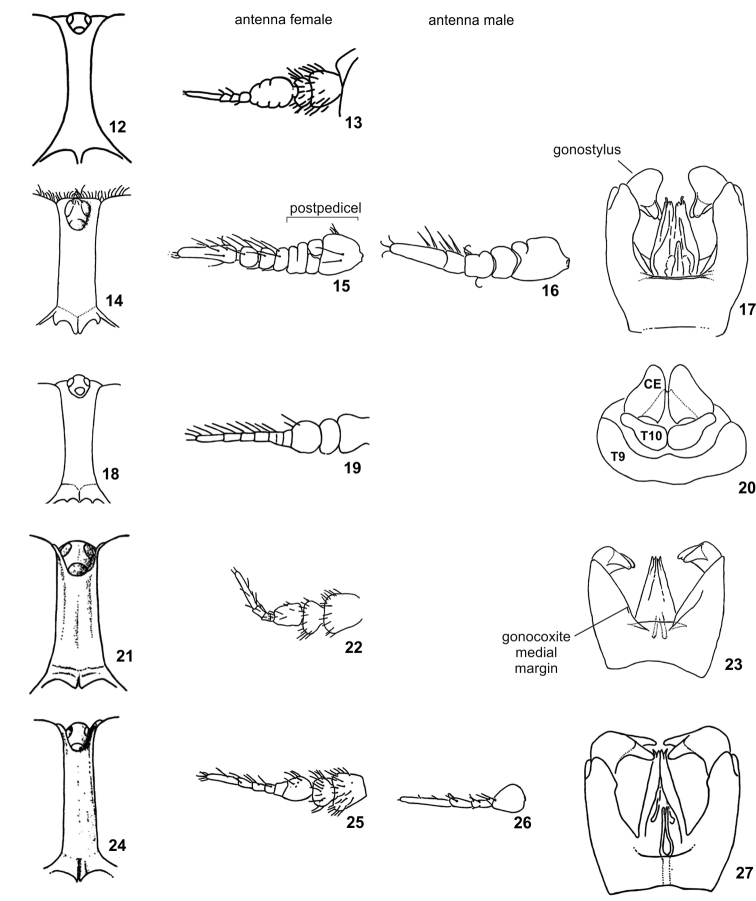
Protosilvius figures from Fairchild (1962). 12–13
Protosilvius longipalpis;12 frons 13 antenna, female 14–17
Protosilvius phoeniculus
14 frons 15 antenna, female 16 antenna, male 17 genitalia, male 18–20 Protosilvius termitiformis
18 frons 19 antenna, female 20 tergite 9, tergite 10 and cercus 21–23
Protosilvius priscus
21 frons 22 antenna, female 23 genitalia, male 24–27
Protosilvius mackerrasi
24 frons 25 antenna, female 26 antenna, male 27 genitalia, male. Figs 12, 14, 18, 21, 24 in frontal view; 13, 15, 16, 19, 22, 25, 26 in lateral view, all arranged in the same orientation, 17, 20, 23, 27 in dorsal view; 7, 11 in ventral view. Abbreviations: CE = cercus, T = tergite.